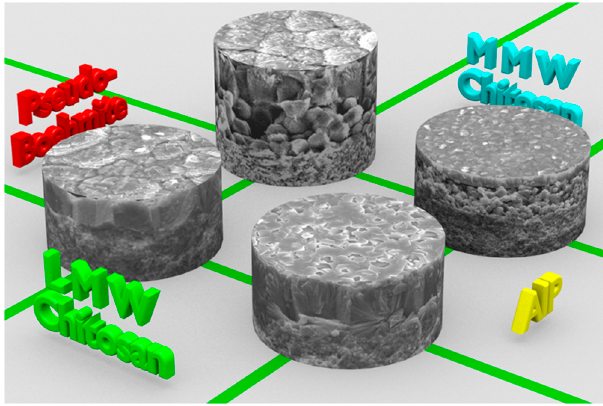
Figure 10. Schematic diagram of manipulating microstructure of AFI membranes using a thin chitosan layer of different molecular weight and different Al sources.